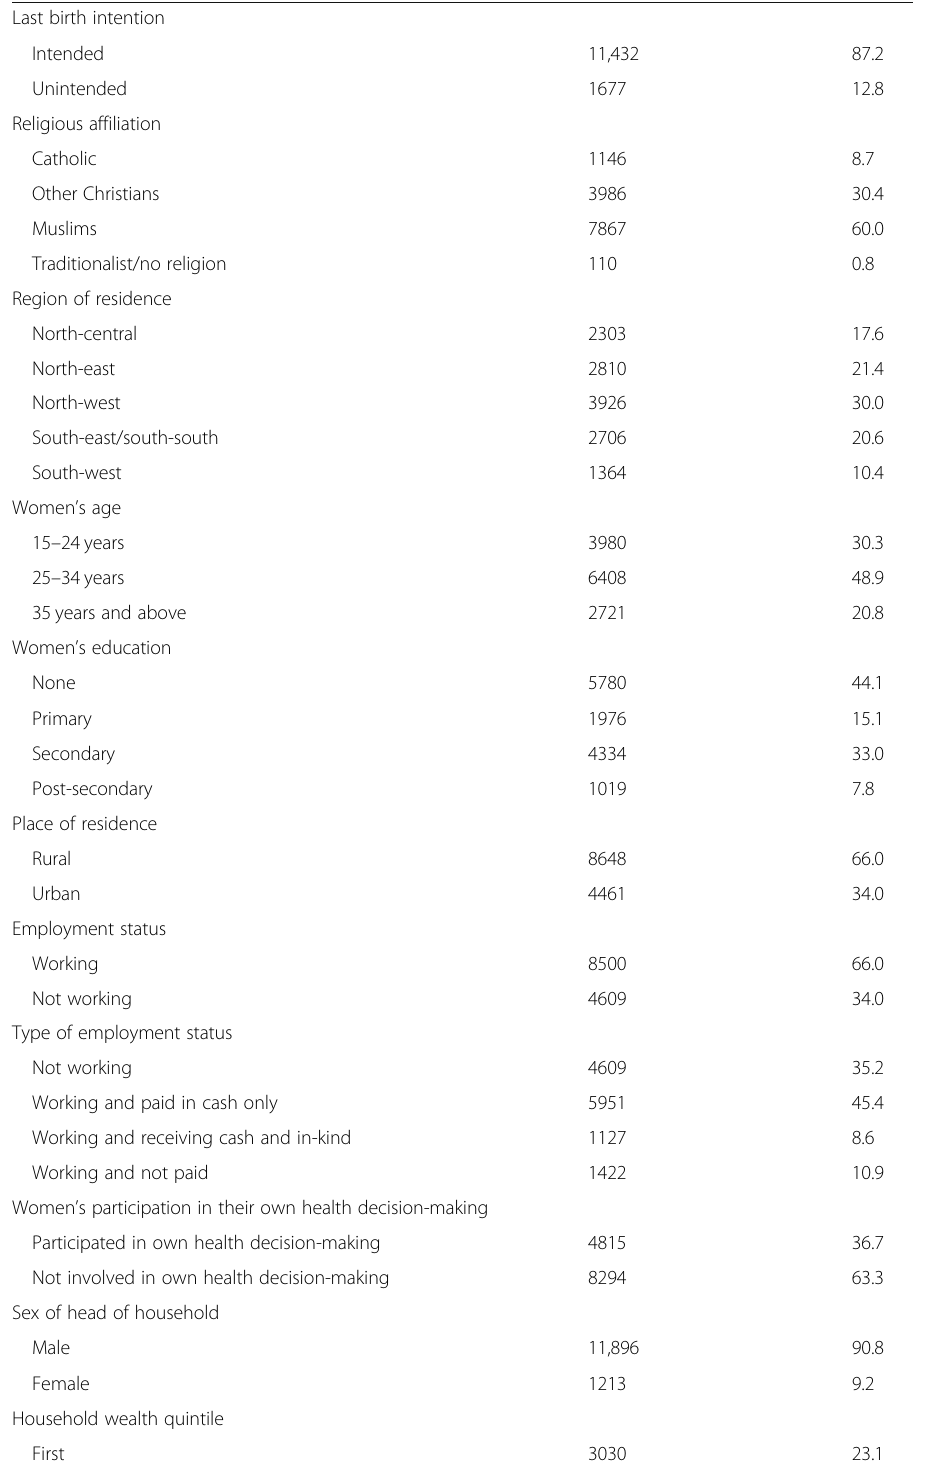
Table 1 Background characteristics of study participants (NDHS 2018), N = 13,109